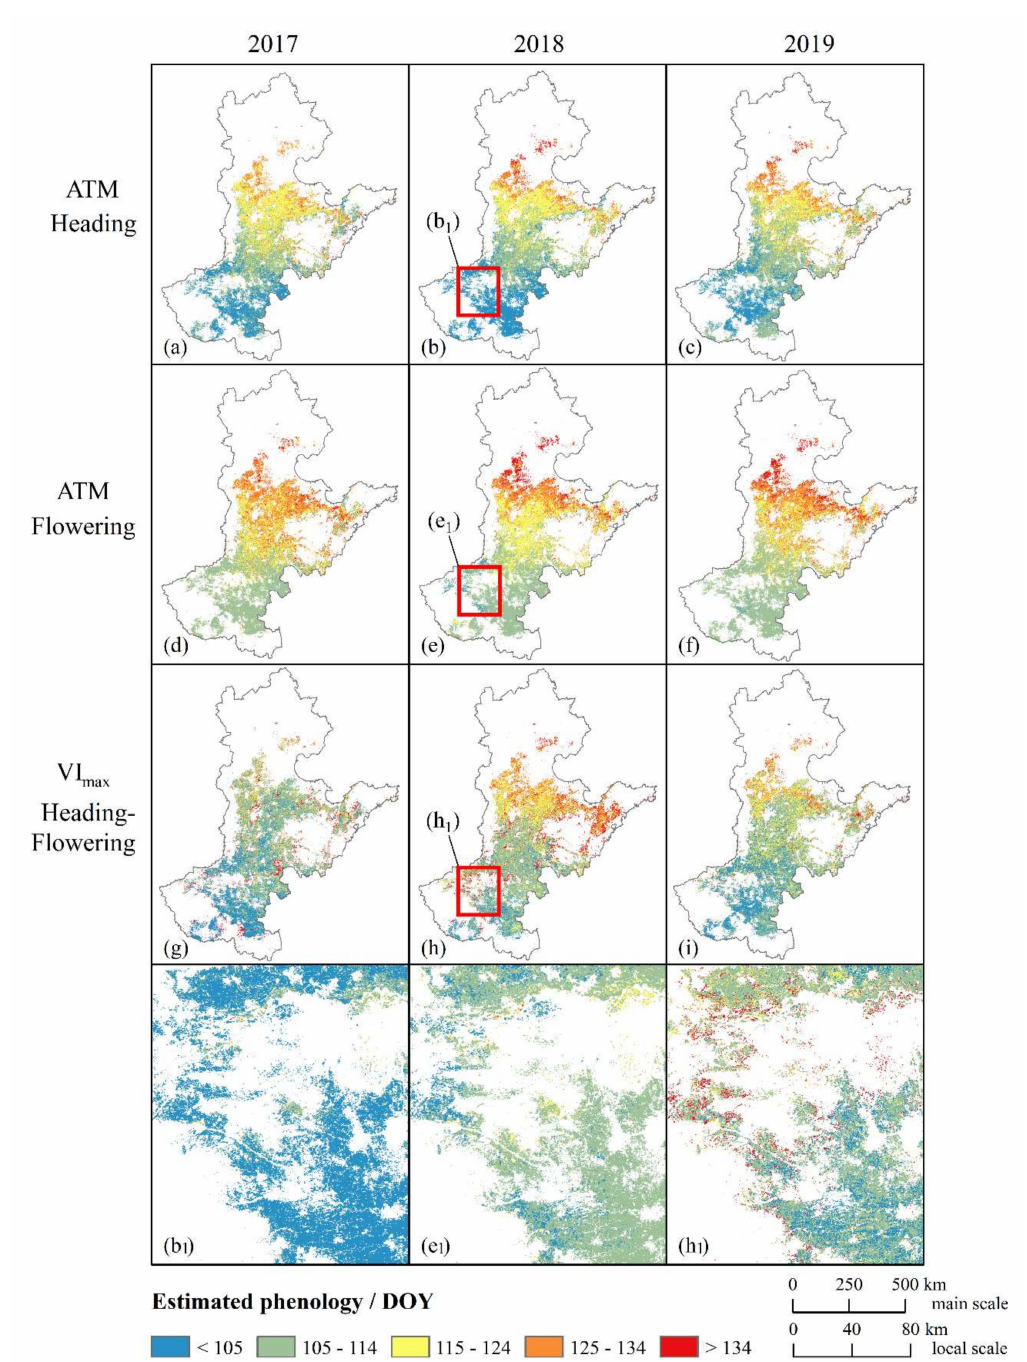
Figure 4. Spatial distributions of estimated phenology from 2017 to 2019 in NCP. ( a – c ) the estimated heading date with the proposed ATM method for 2017, 2018, and 2019, respectively; ( d – f ) the estimated flowering date with the proposed ATM method for 2017, 2018 and 2019, respectively; ( g – i ) the estimated heading–flowering date with the VI max method for 2017, 2018 and 2019, respectively; and ( b 1 , e 1 , h 1 ) are the zoom-in figures of ( b , e , h ), respectively. DOY: Julian day of